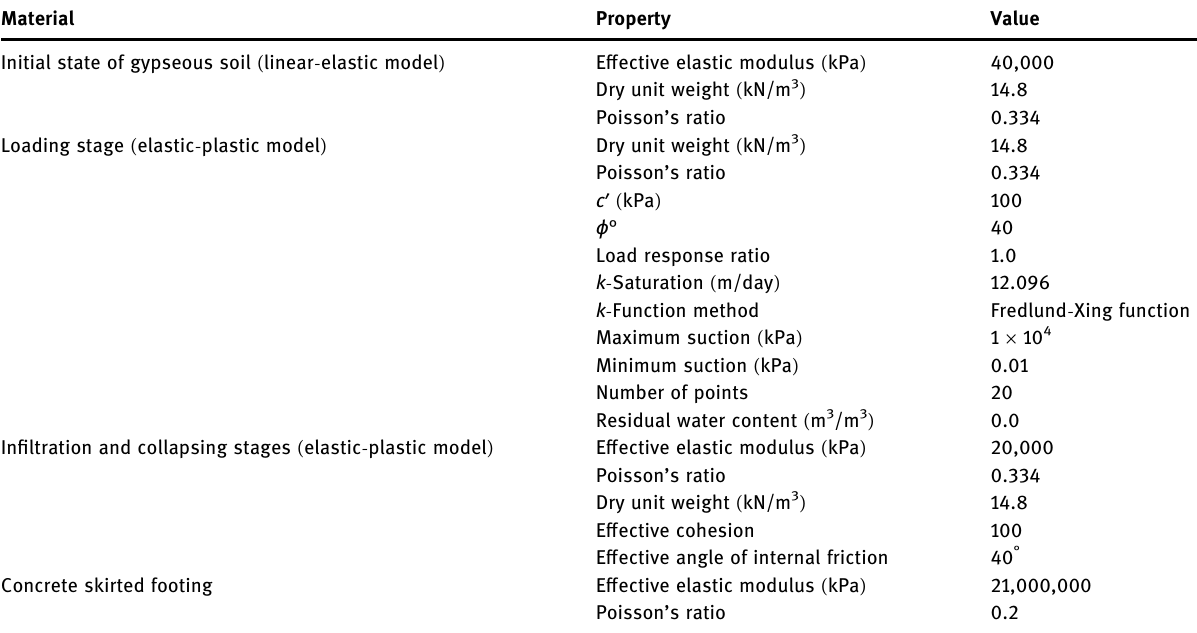
Table 2: Parameters for input of the FEM analysis of gypseous soil Material Property Initial state of gypseous soil ( linear - elastic model )